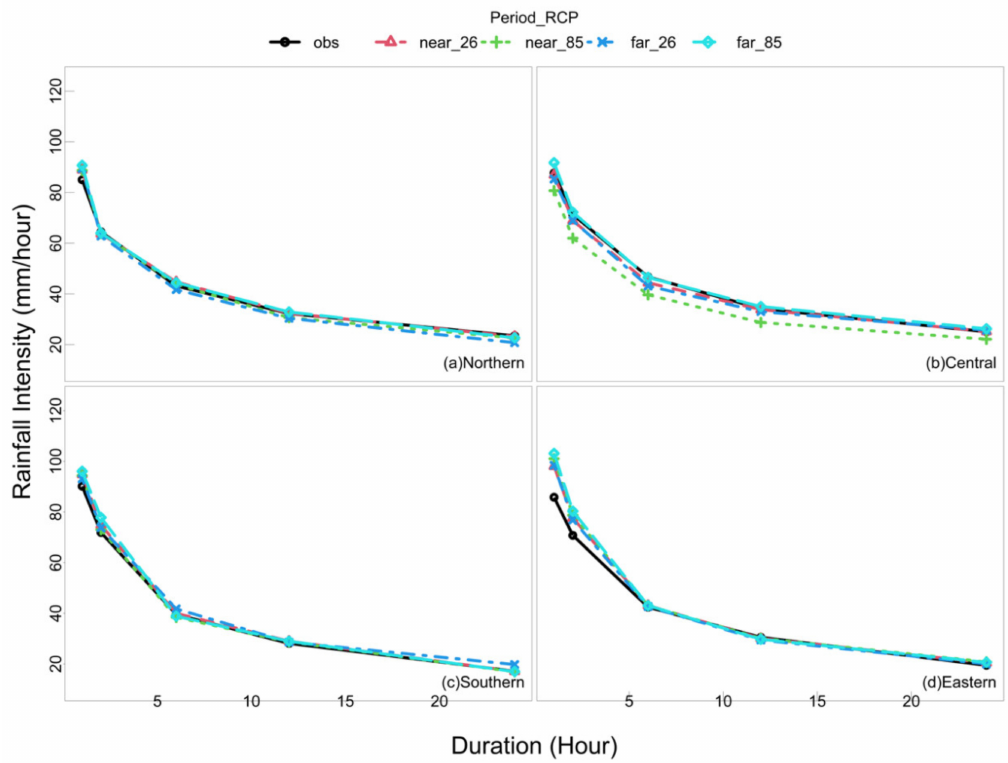
Figure 13. Rainfall intensities of events with twenty-five-year return period (T25) changing with the durations for the four regions and four